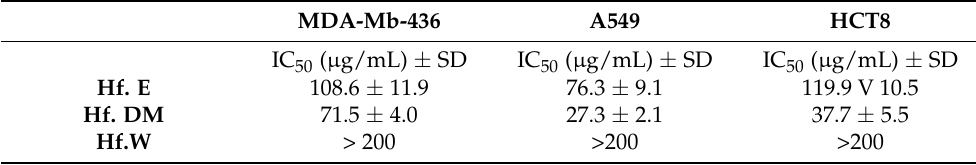
Table 5. Hypericum foliosum extracts’ selective cytotoxic